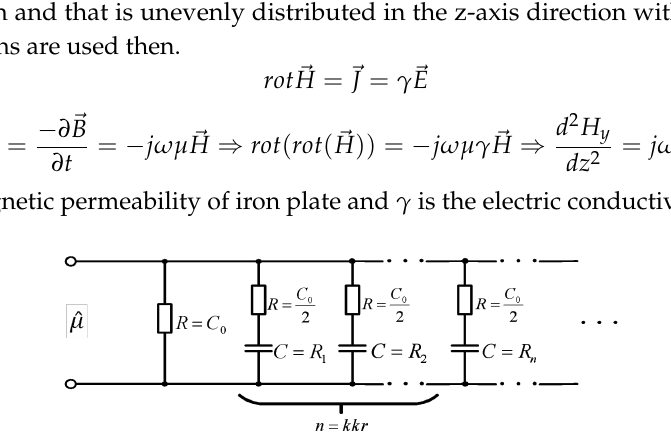
Figure 1. Synthesis of the equivalent magnetic permeability, ˆ µ , in the form of an R,C